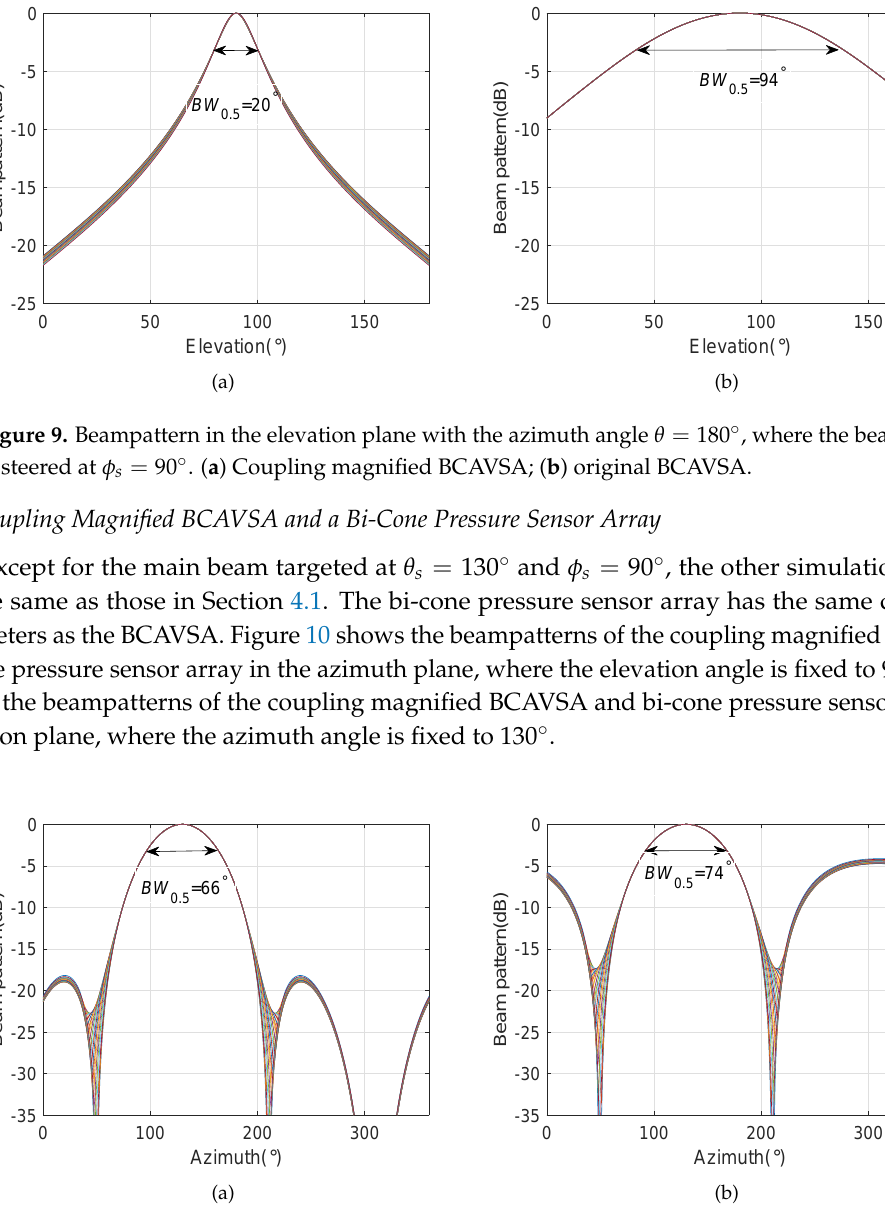
Figure 10. Beampatterns of the coupling magnified array in the azimuth plane with the elevation angle φ = 90 ◦ , where the beampattern is steered at θ s = 130 ◦ . ( a ) BCAVSA; ( b ) bi-cone pressure sensor